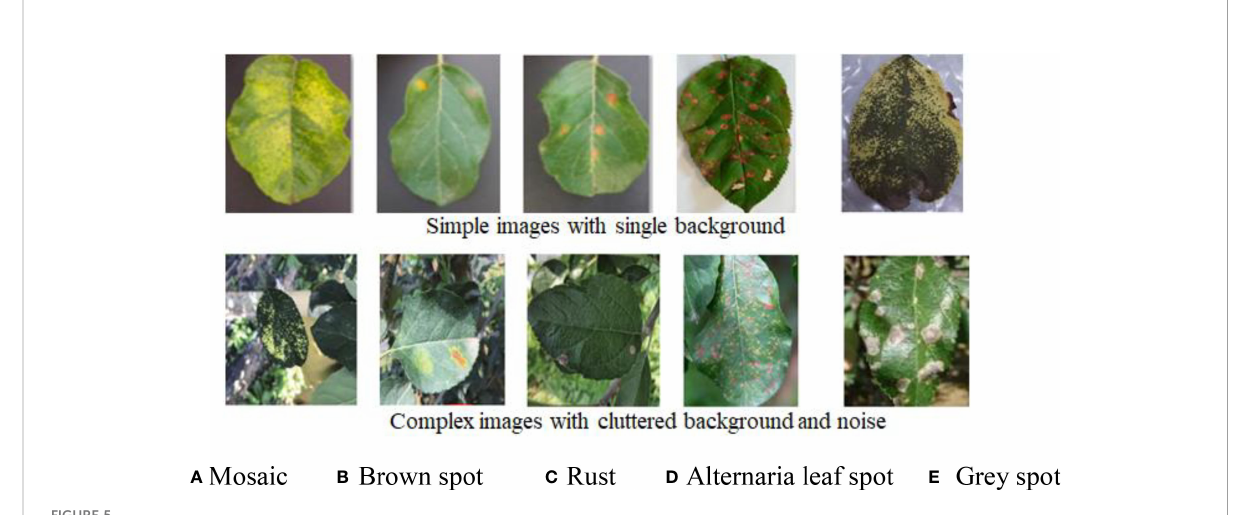
FIGURE 5 Ten image examples of fi ve kinds of diseases. (A) Mosaic. (B) Brown spot. (C) Rust. (D) Alternaria leaf spot. (E) Gray spot.